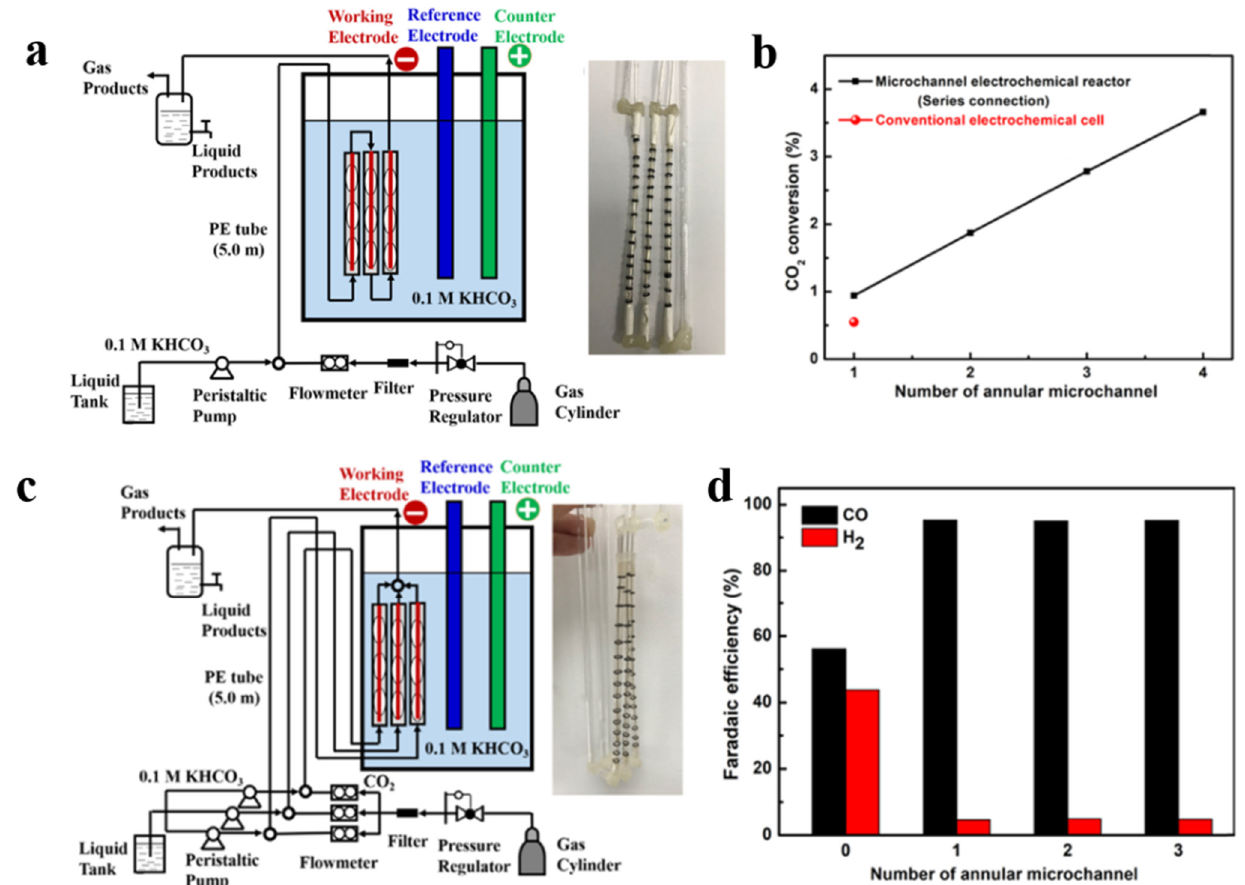
Figure 10. ( a ) Diagram of the microchannel reactor with three microchannels in series. ( b ) CO 2 conversion vs. number of annular microchannels. ( c ) Diagram of the microchannel reactor with three microchannels in parallel. ( d ) FE CO , FE H2 vs. number of annular microchannels. Reproduced with permission from Ref. [136]. Copyright 2020 American Chemical Society.